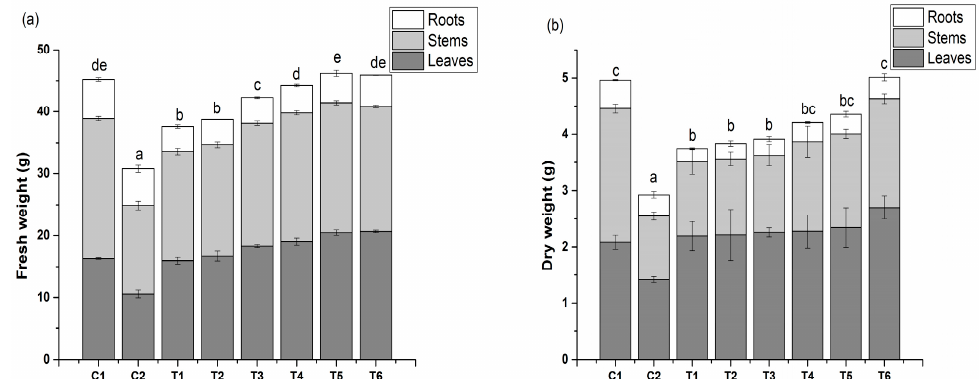
Figure 1. E ff ects of indole-3-acetic acid (IAA) on the fresh weight ( a ) and dry weight ( b ) of spinach seedlings under Cu stress. Values and error bars indicate means ± standard deviation ( n = 3). Di ff erent letters indicate a significant di ff erence between treatments at p < 0.05 according to Duncan’s multiple-comparisons test.